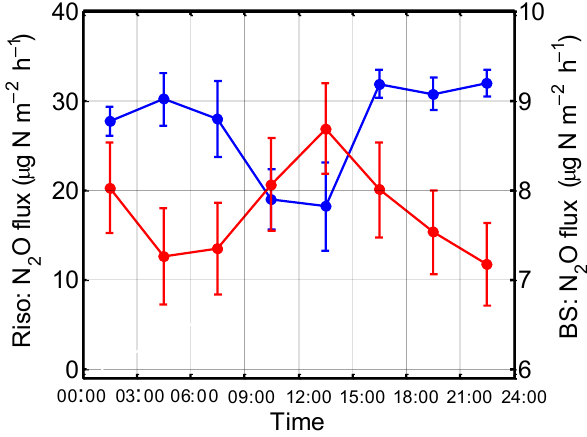
Figure 8. Mean diurnal courses of N 2 O fluxes derived from QCL flux measurements during the Risø (blue line) and Braunschweig (red line) campaign. To exclude fertilization effects in Risø, only data from the low-flux period (DOY<105.5 and >108.5) were